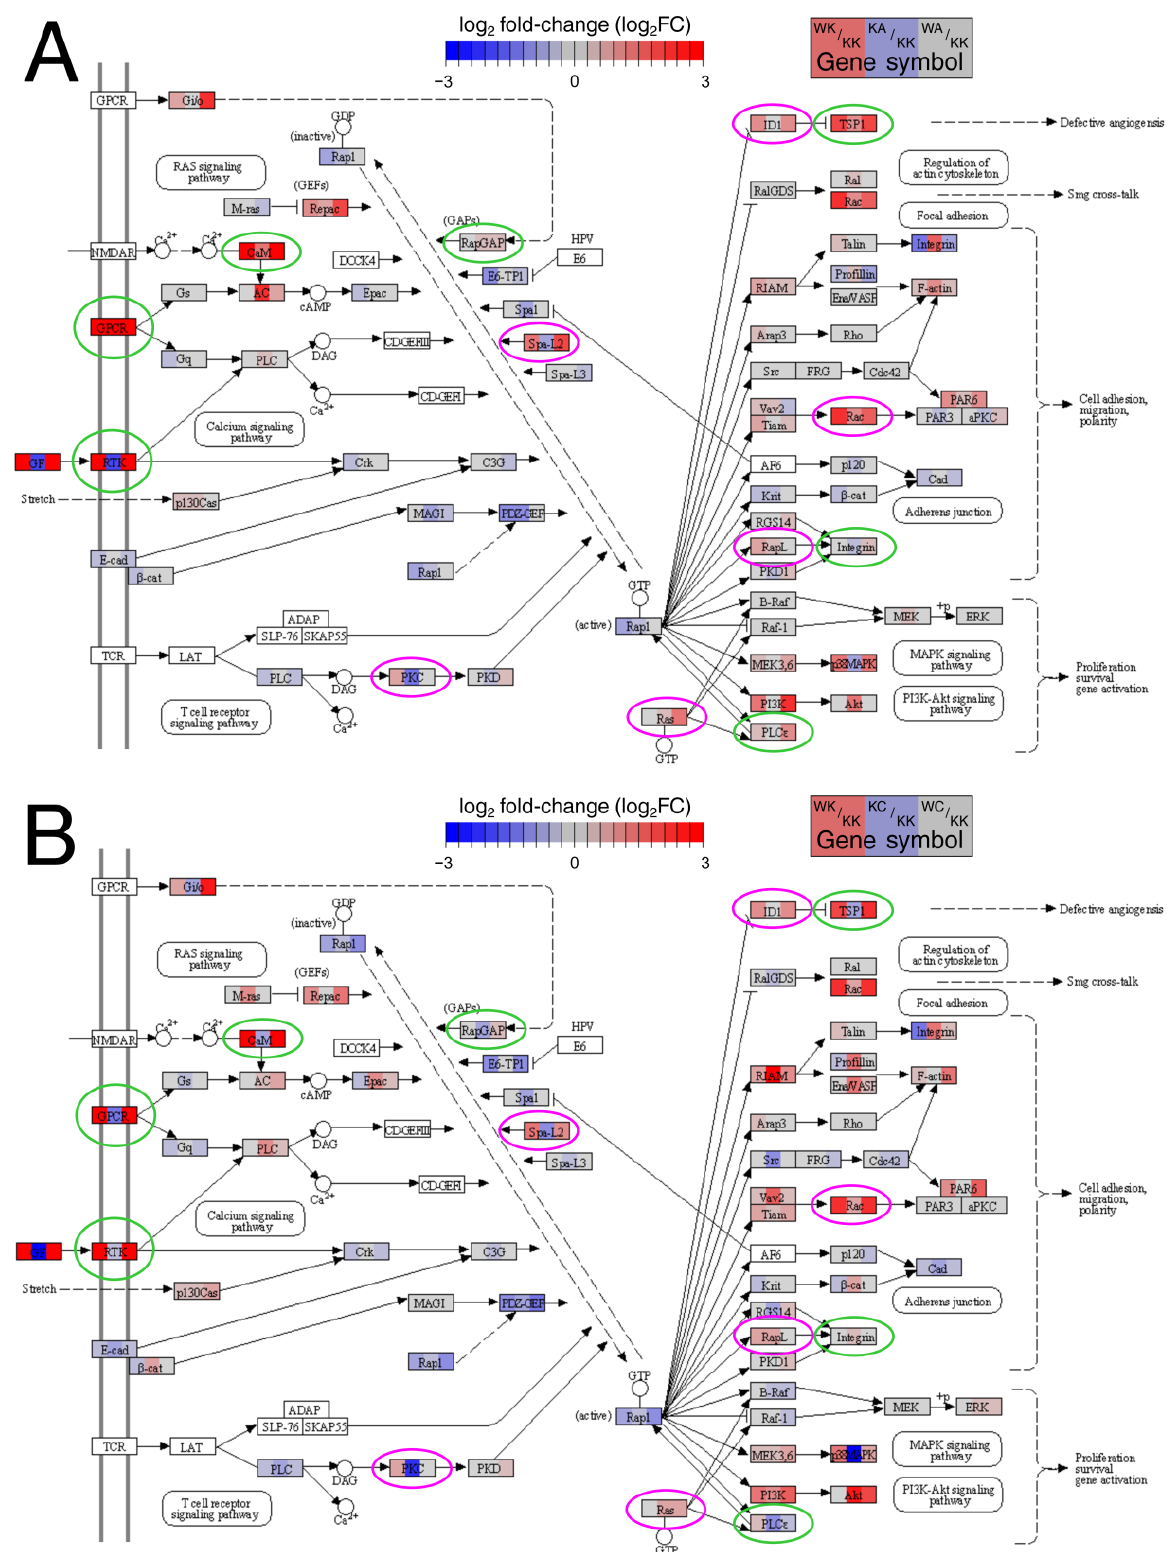
Figure 4. Example differences and similarities in the Rap1 signaling pathway between ( A ) ‘alpha’ and ( B ) ‘gamma’ comparisons. Differences are marked in green while similarities in pink.